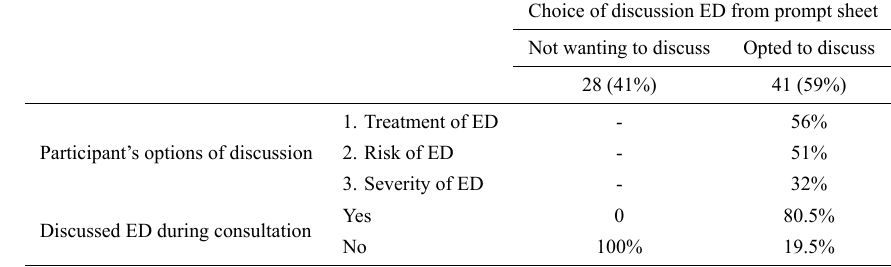
Table 2a. Intervention group response to prompt sheet (n = 69).